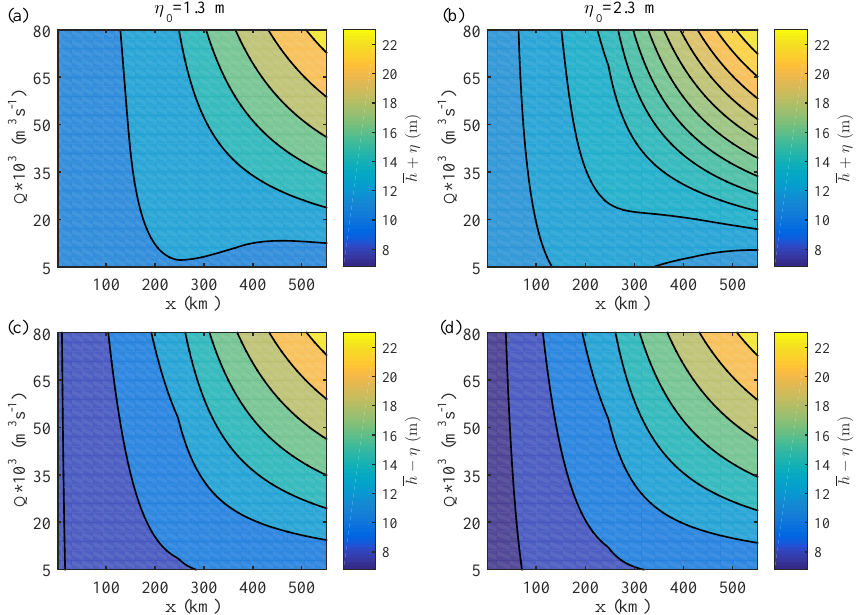
Figure 12. Longitudinal variation of the high water level h + η (a, b) and low water level h − η (c, d) as a function of fresh water discharge for given tidal amplitude at the estuary mouth – (a, b) η 0 = 1 . 3m representing the mean tidal amplitude; (c, d) η 0 = 2 . 3m representing the spring tidal